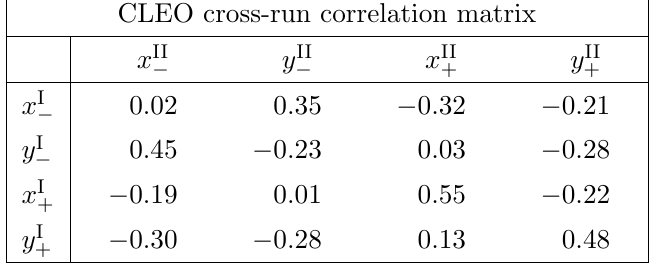
Table 5 . Correlation matrix between Run 1 results (I) and the results presented in this paper (II), when (cid:12)tting data while varying the inputs from the CLEO collaboration in a correlated way.